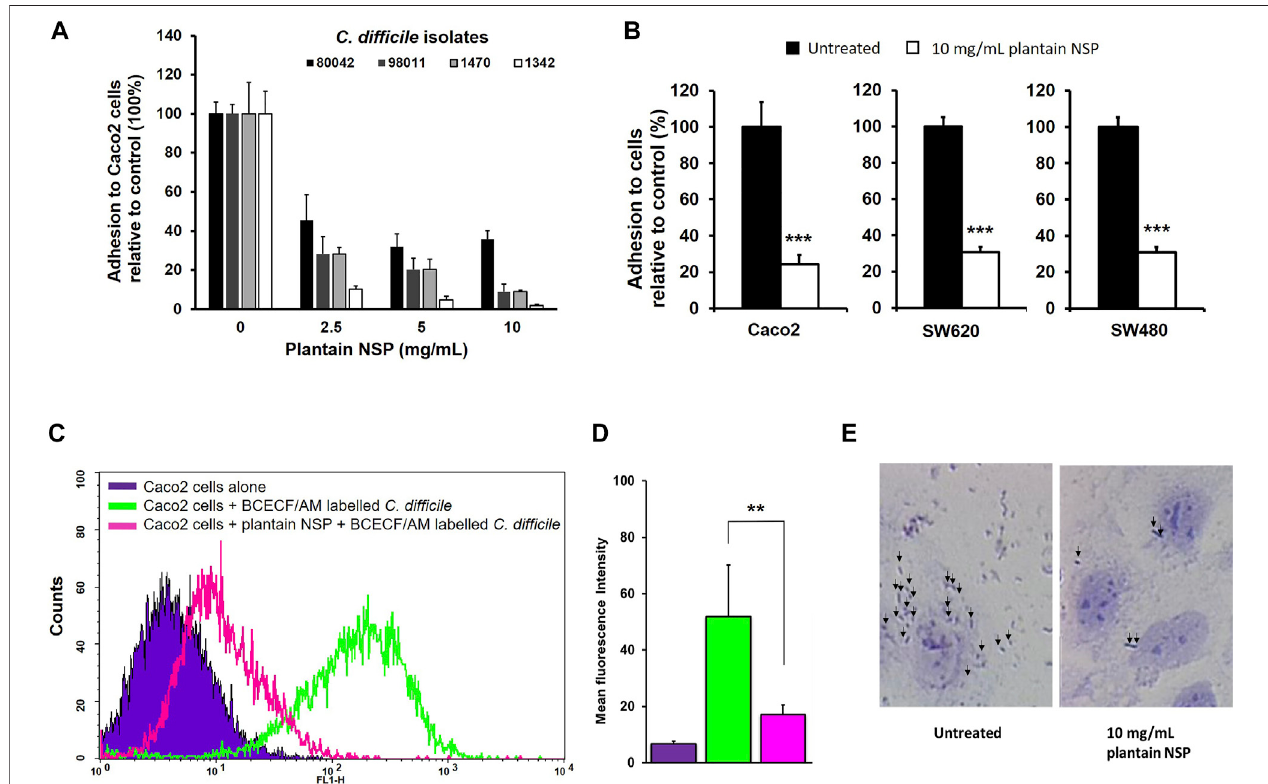
FIGURE1| Solublenon-starchpolysaccharidesfrom plantaininhibits C.dif fi cile adhesion tointestinal epithelialcellsinadose-dependent manner. (A) Adhesion of C. dif fi cile isolate 80042 to con fl uent Caco-2 [Caco2] monolayers are signi fi cantly inhibited in the presence of plantain (NSP). (B) Pre-treatment with 10 mg/ml plantain NSP, blocked adhesion of C. dif fi cile 80042 to three different intestinal cell-lines Caco-2, SW480 and SW620. Adhesion is expressed relative to CFU/mL found in the absenceofplantainsolubledietary fi bre,setas100%( N (cid:2) 3experiments, n (cid:2) 3replicates; ** p < 0.01,*** p < 0.001;Kruskal-WallistestorMann WhitneyUtest). (C) Flow cytometric analysis of 1 × 10 6 Caco-2 cells in suspension, either uninfected (blue), co-incubated with 1 × 10 8 BCECF/AM-labelled C dif fi cile 80042 for 1 h, either without (green), or with 30 min pre-treatment with 10 mg/ml plantain NSP (pink). (D) Data are based on 10,000 events, and representative of N (cid:2) 4 separate experiments. Signi fi cant effect of NSP, as assessed by shift in mean fl uorescence intensity, compared to infected controls (** p < 0.01, Kruskal-Wallis test). (E) Giemsa- stained C. dif fi cile 80042 inoculated Caco-2 cells in the absence and presence of 10 mg/ml plantain NSP. Black arrows indicate adherent bacteria.